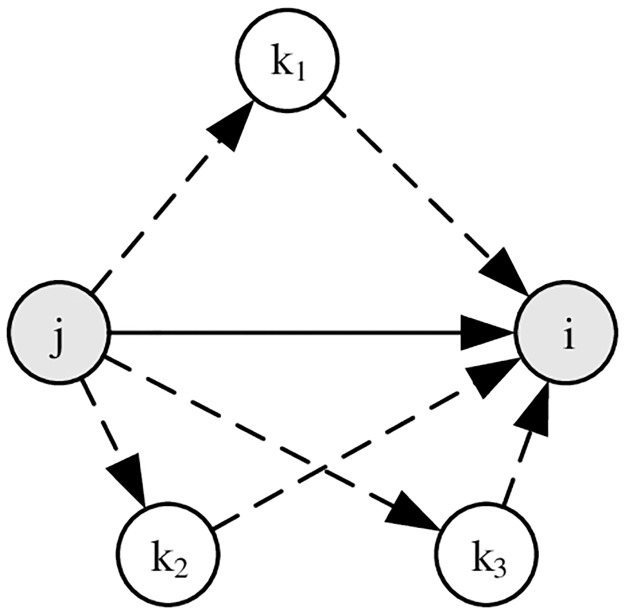
Relationships between SDN nodes.